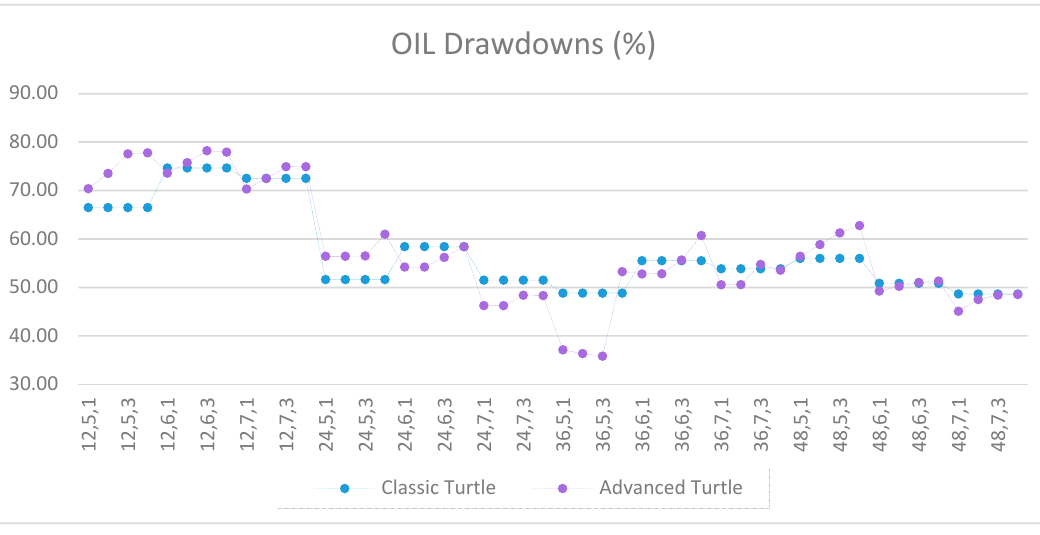
Figure A62. Drawdowns of OIL as percentage of equity between the classic and the advanced Turtle systems for every combination of N, X, Y for the slow parameters (80, 160), where X ≥ 5.